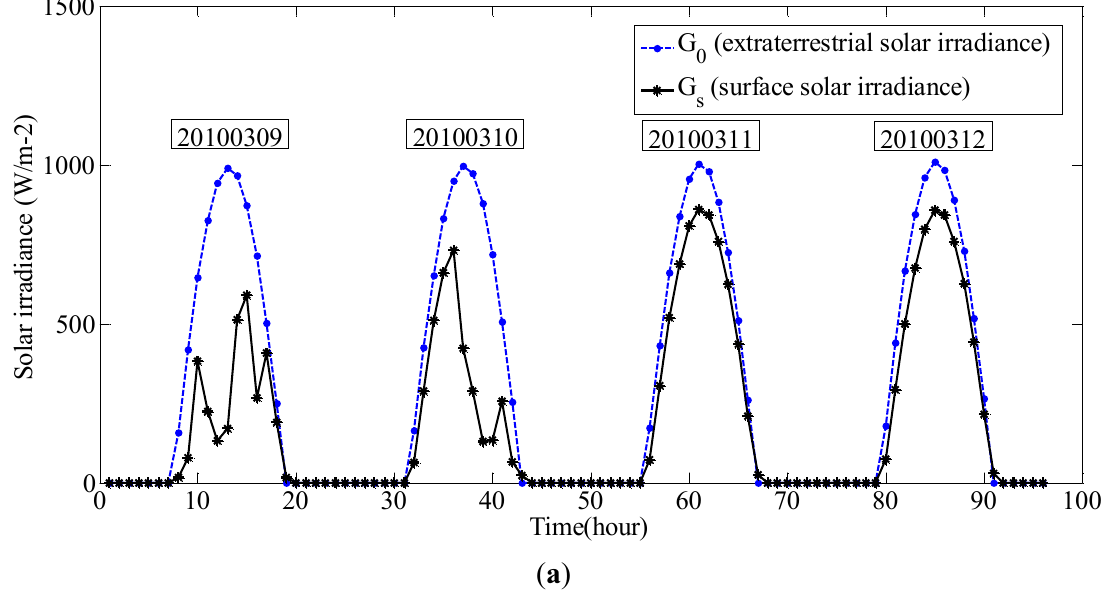
Figure 1. Extraterrestrial irradiance, surface irradiance and solar irradiance difference; ( a ) Extraterrestrial irradiance and surface irradiance; ( b ) Solar irradiance